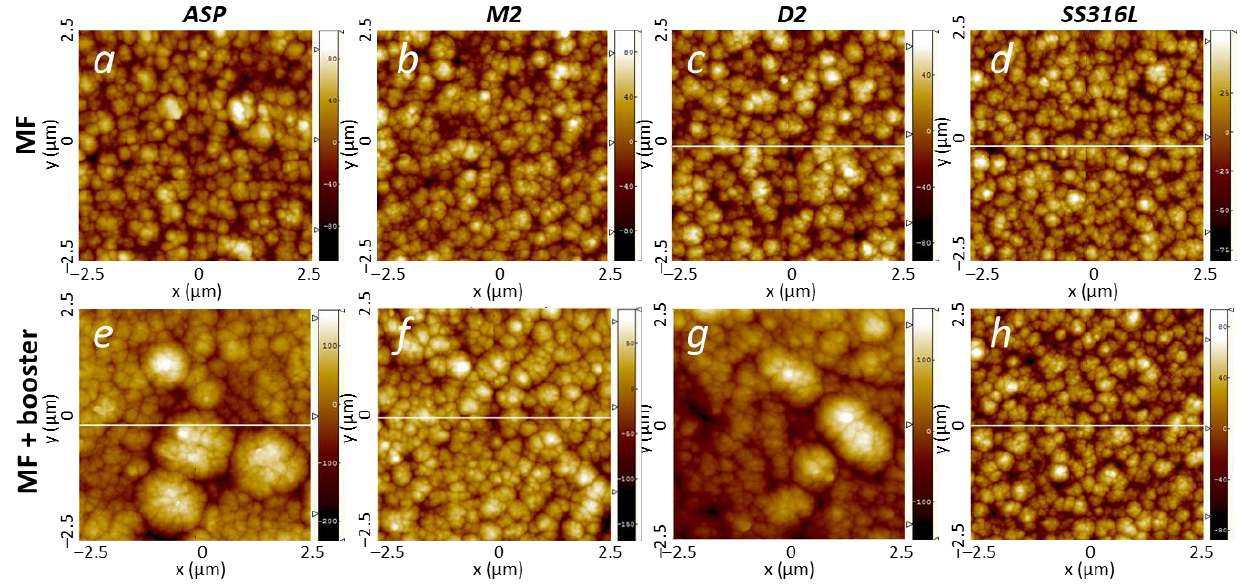
Figure 10. AFM images of surface morphology of the NL-TiAlN/CrN coating deposited in the same batch on four different steel substrates (ASP30, M2, D2 and SS316L) ion etched by MF ( top row) and MF and booster techniques ( bottom row).